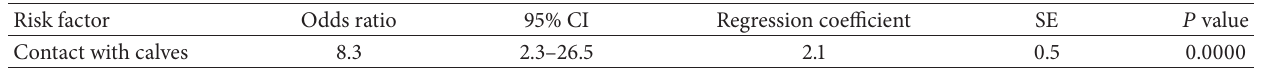
Table 6: Final model of multivariate analysis of Cryptosporidium parvum infection risk factors. Risk factor Odds